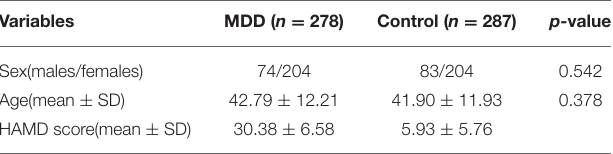
TABLE 2 | The characteristics of